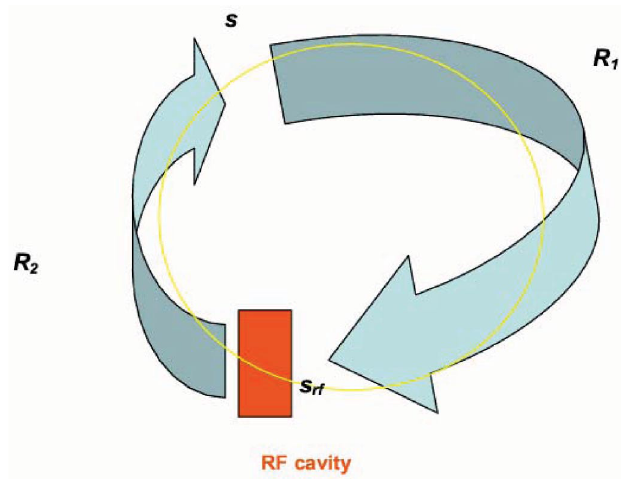
FIG. 1. (Color) Sketch of a ring with one